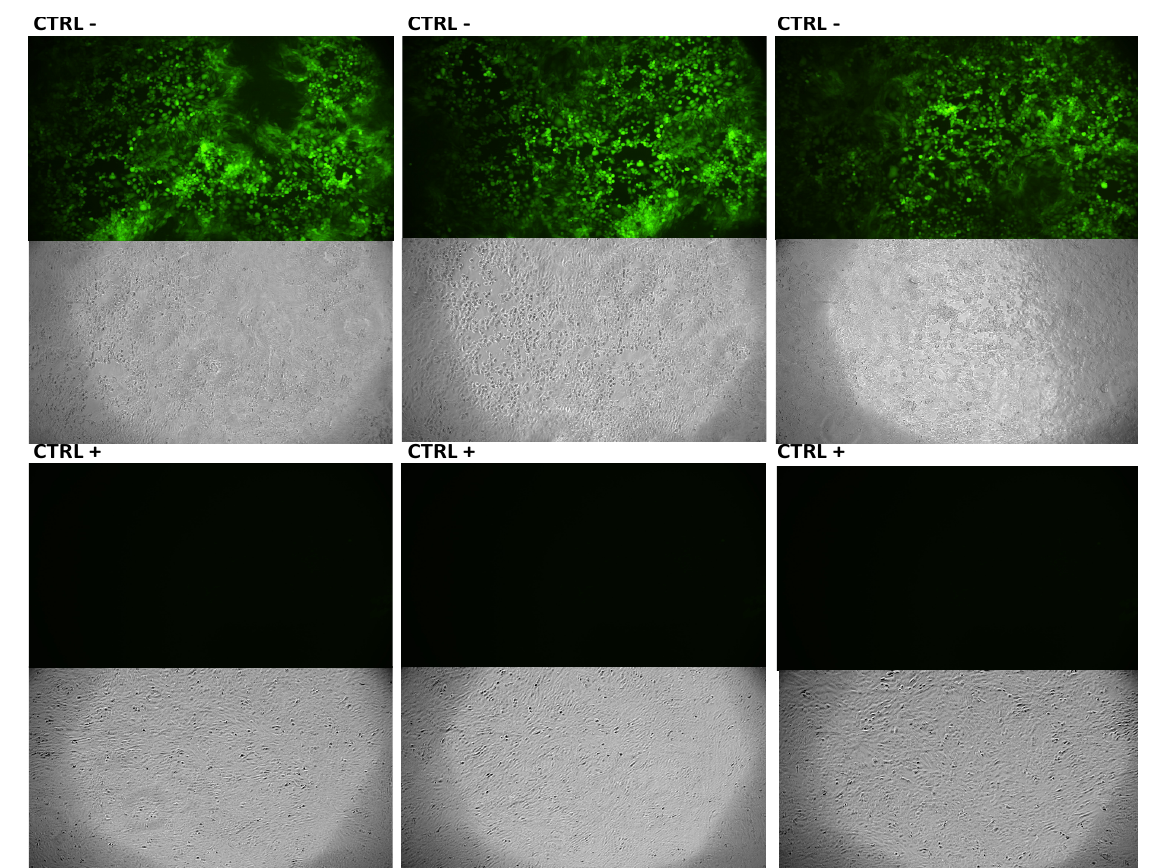
Figure 3. Antiviral activity of M, H, and EA, against HSV-1-GFP. Plaques were viewed with RGB and fluorescent microscopy. ( A – C ): M, H, and EA treatments at a 0.62 µg/mL; ( D – F ): M, H, and EA treatments at a 0.31 µg/mL; ( G – I ): M, H, and EA treatments at a 0.16 µg/mL; ( J – L ): M, H, and EA treatments at a 0.08 µg/mL; CTRL : cells infected with the virus; CTRL+: cells uninfected.